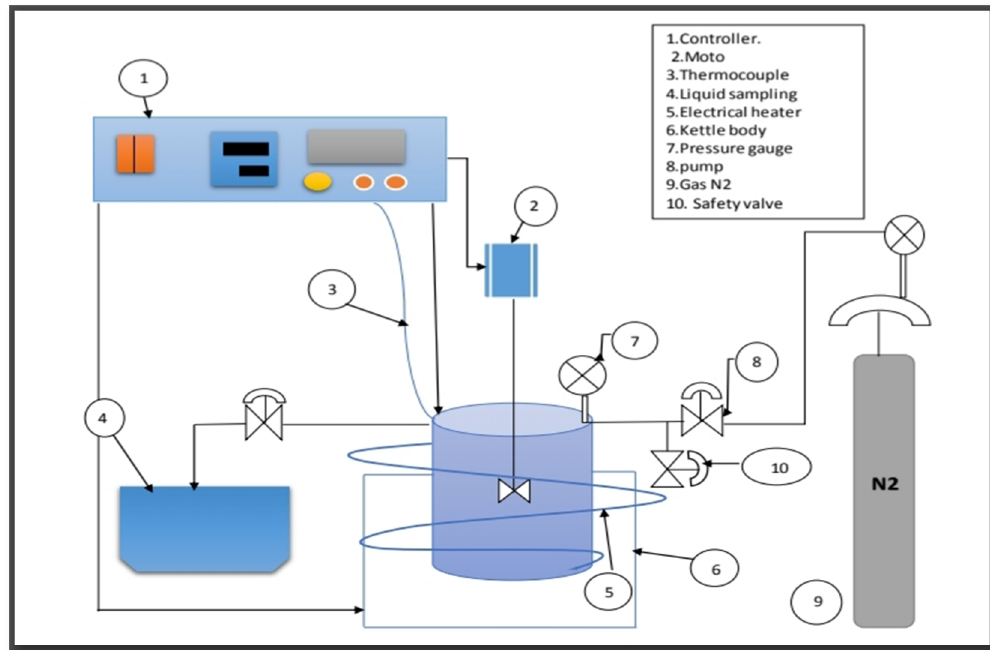
Figure 4. Schematic diagram of the used batch reactor.